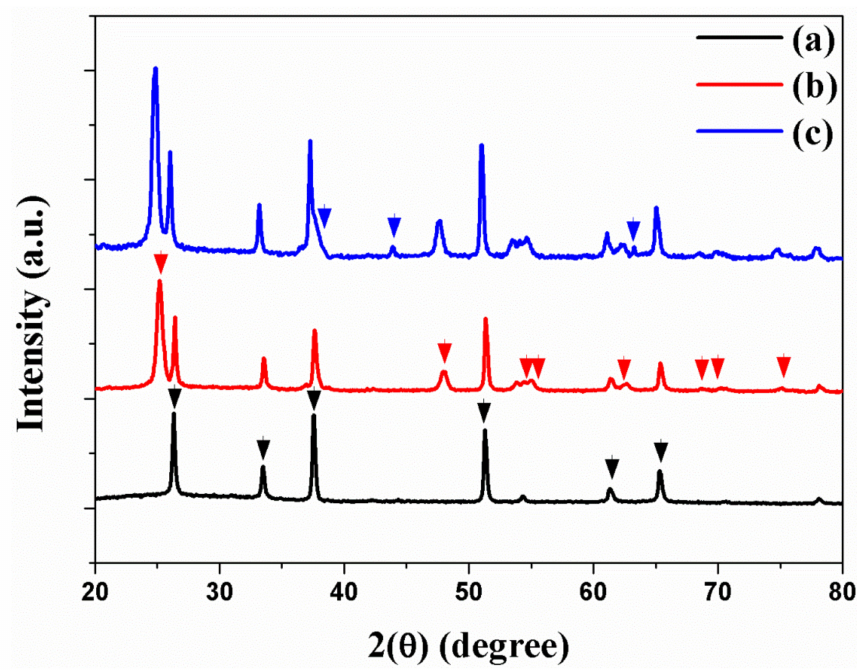
Figure 3. XRD of ( a ) FTO, ( b ) freestanding TNTAs, and ( c ) freestanding TNTAs with Au NPs.